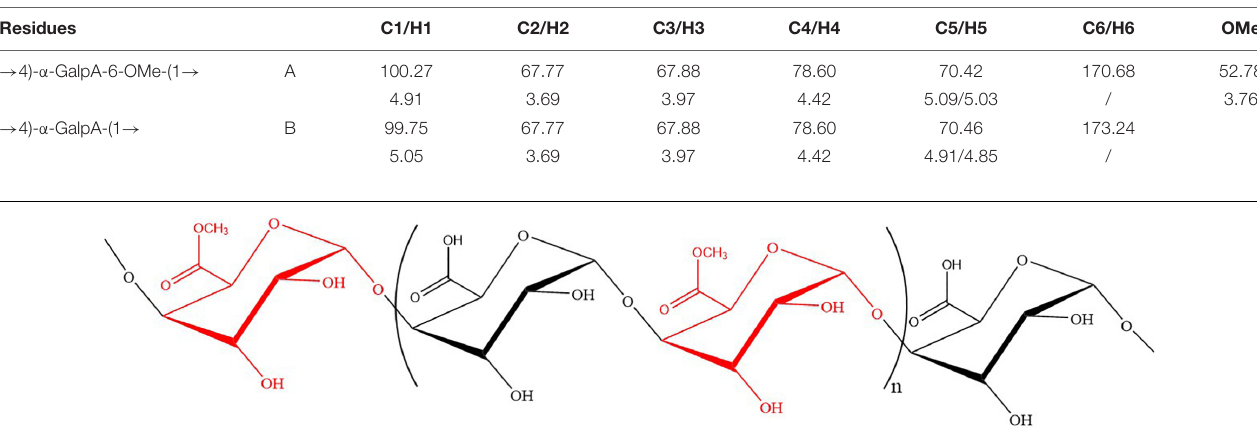
FIGURE 6 | Homogalacturonan (HG) backbone of